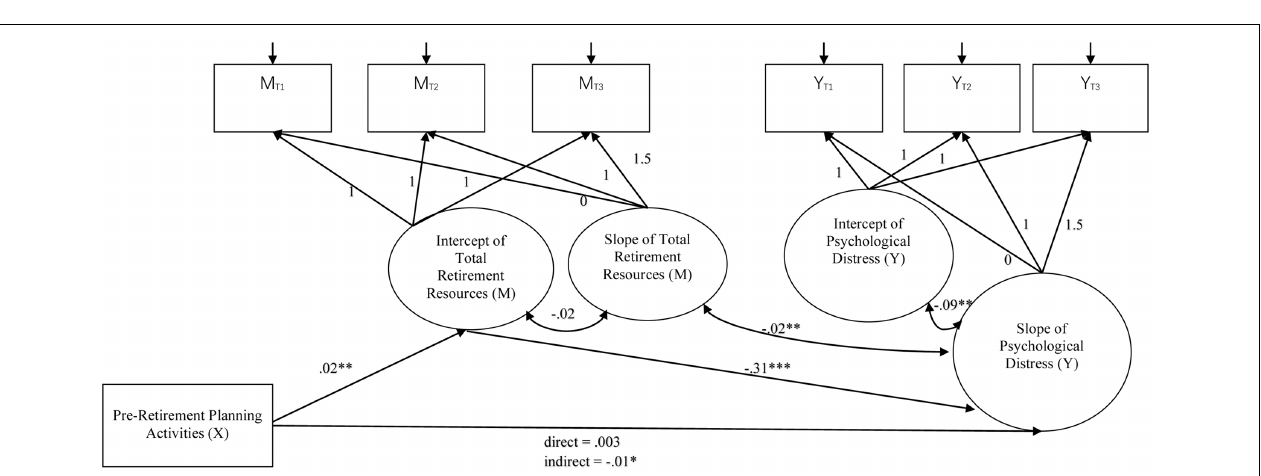
FIGURE 4 | The latent growth mediation model on psychological well-being. X denotes the independent variable; M denotes the mediator; and Y denotes the dependent variable. The model fit indices are: CFI = 0.901; RMSEA = 0.150; AIC = 250.945; BIC = 325.754. Age and gender were controlled in the model as covariates. ∗ p < 0.05; ∗∗ p < 0.01; ∗∗∗ p < 0.001.